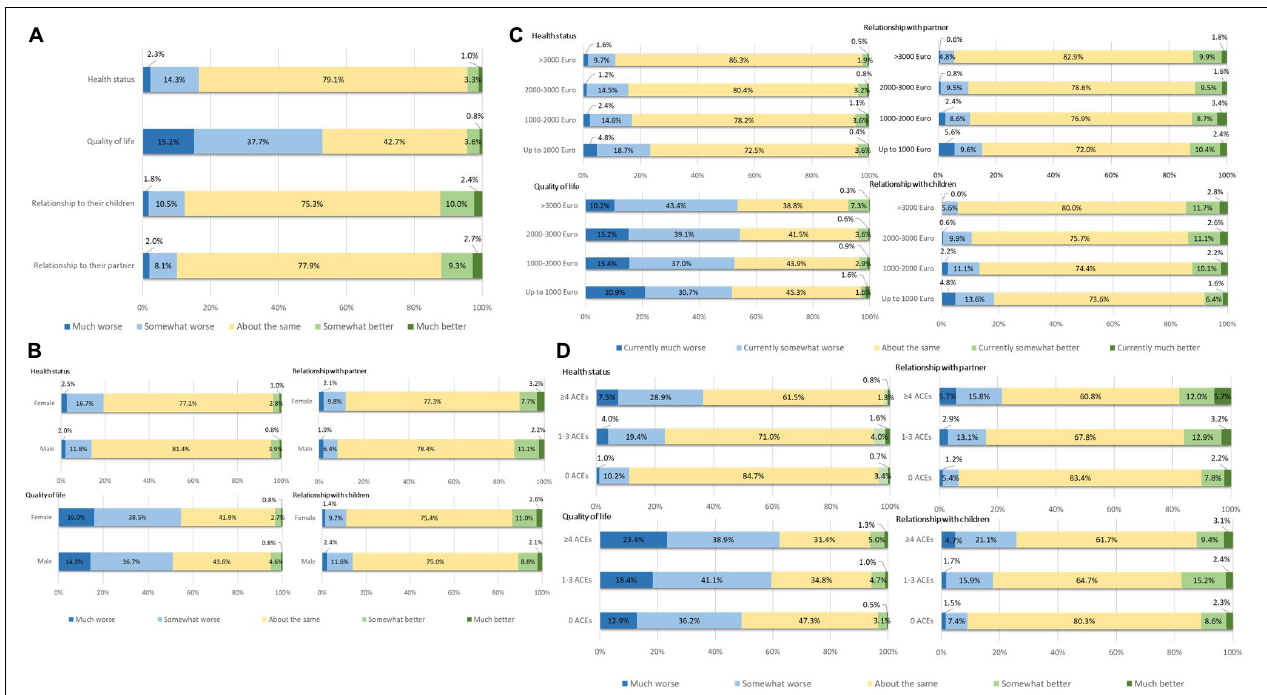
FIGURE 1 | Impact of COVID-19 and associated measures on health, quality of life and intrafamilial relations. (A) General impact. Impact in dependence of gender (B) , household income (C) , and adverse childhood experiences (D)